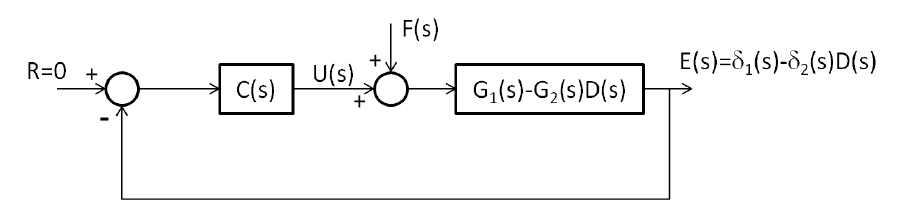
Figure 7. The linearized feed-forward control